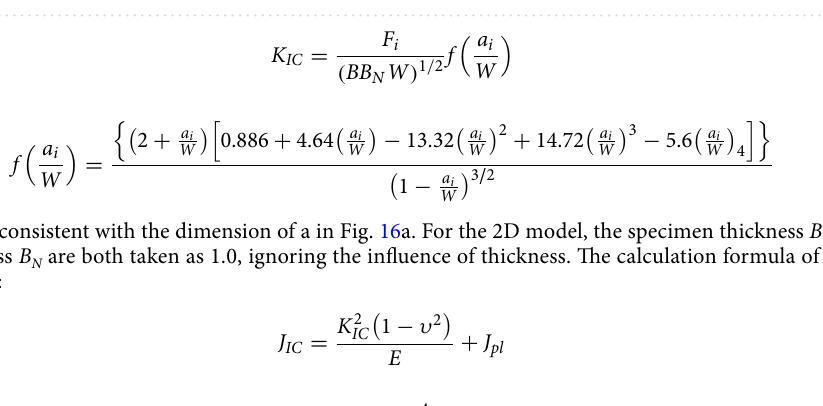
Table 10. Results of fracture toughness calculated by finite element method of different models at macro